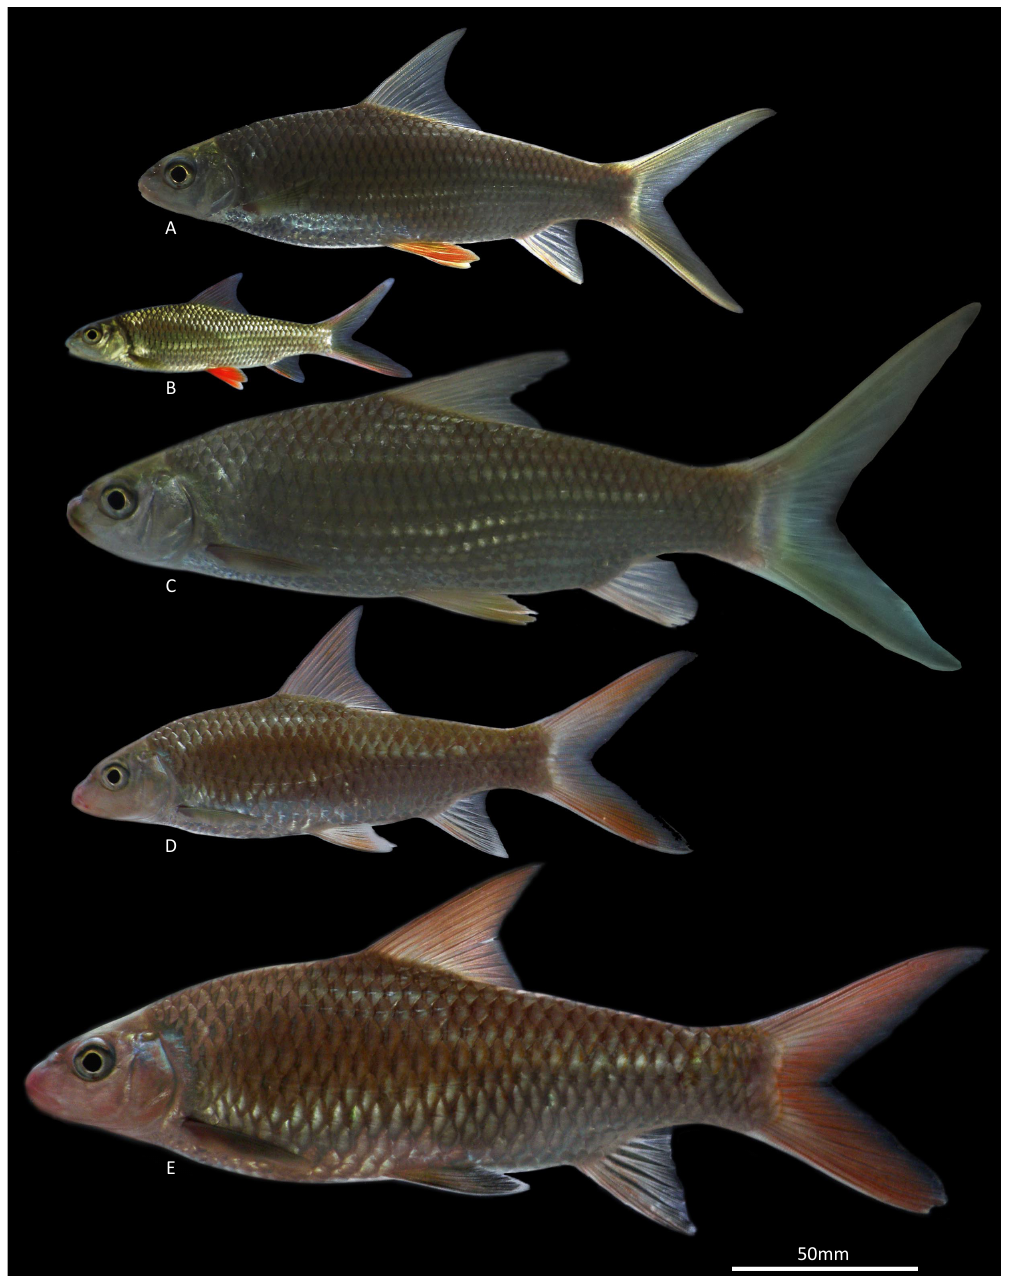
Image 2. Hypselobarbus lithopidos: A - Phalguni River, Mangalore, Karnataka (ZSI ZSC F 8663); B - Phalguni River, Mangalore, Karnataka, unregistered specimen; C - Phalguni River, Karnataka (MKC 403); Hypselobarbus thomassi : D - Chalakudy River, Kerala (ZSI ZSC F 8665); E - Kempu Hole River, tributary of Netravathi, Karnataka (MKC 404). © J.D.M.